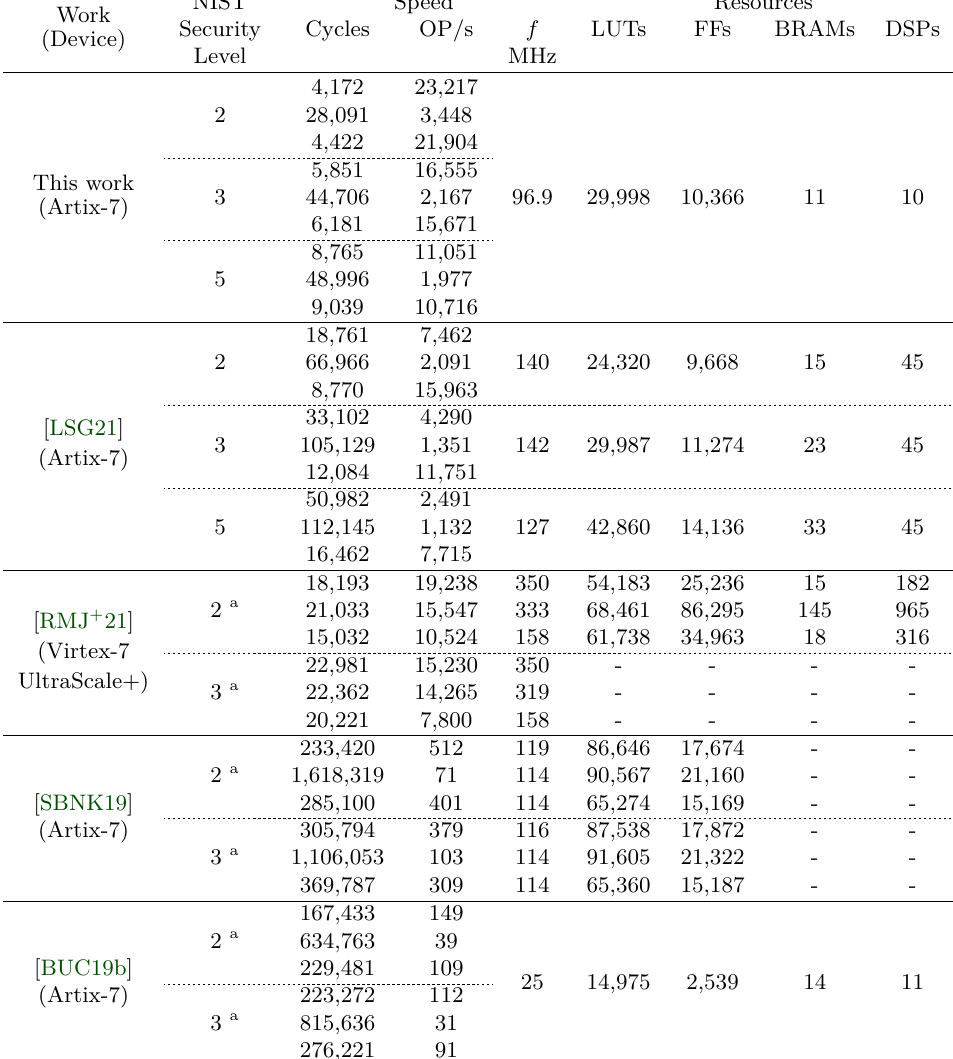
Table 5: Comparison with related works. For each security level, the three rows of speed and resource results correspond to three phases: KeyGen , Sign and Verify